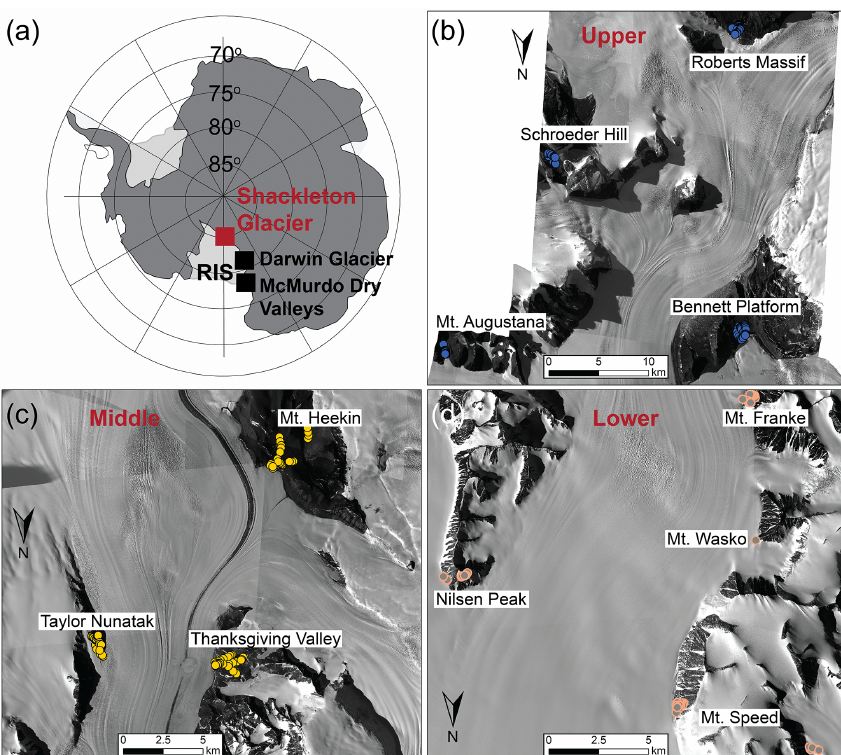
Figure 1. Samples were collected and analyzed from the exposed soils along the Shackleton Glacier, a major outlet glacier of the EAIS (a) , in three zones. The upper zone (b) was located at the head of Shackleton Glacier, the middle zone (c) was the central portion, and the lower zone (d) was at the terminus of the glacier where it drains into the Ross Sea. Satellite images were provided courtesy of the Polar Geospatial Center (PGC). The Ross Ice Shelf (RIS) is indicated in panel (a)